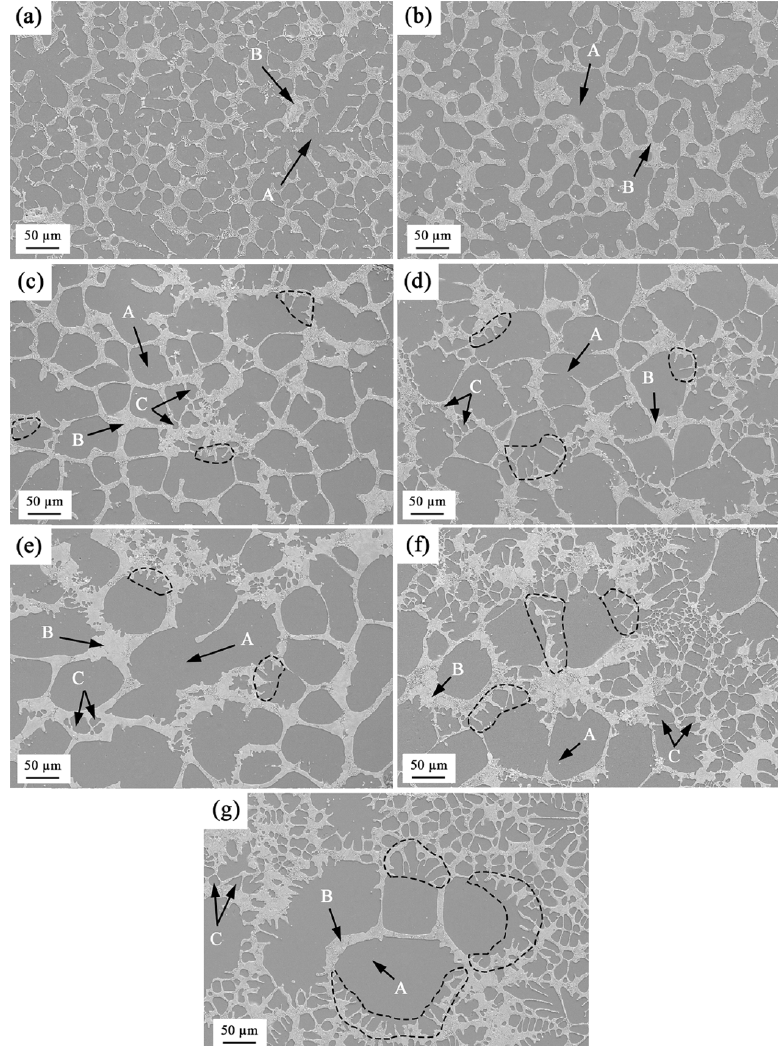
Figure 5. SEM microstructures of a semi-solid Mg–10Zn–6.8Gd–4Y alloy after an isothermal heat treatment at 580 °C for different holding times: ( a ) 2.5 min; ( b ) 5 min; ( c ) 10 min; ( d ) 15 min; ( e ) 30 min; ( f ) 60 min; ( g ) 120 min. A, B, and C indicate primary α-Mg grains, eutectic structures, and eutectic Mg grains, respectively.